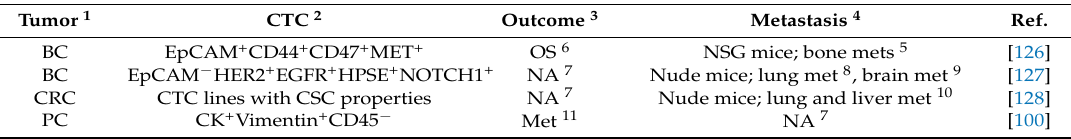
Table 2. CTCs contribute to